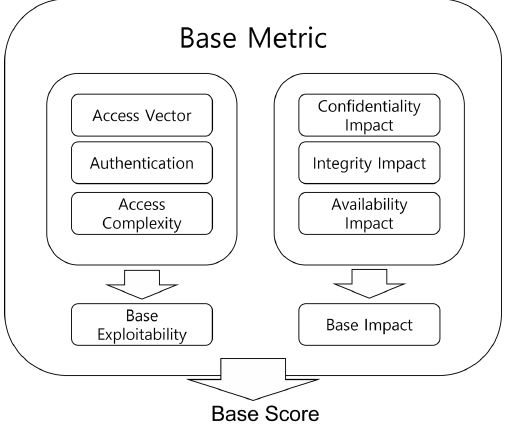
Figure 4. CCSS base metrics